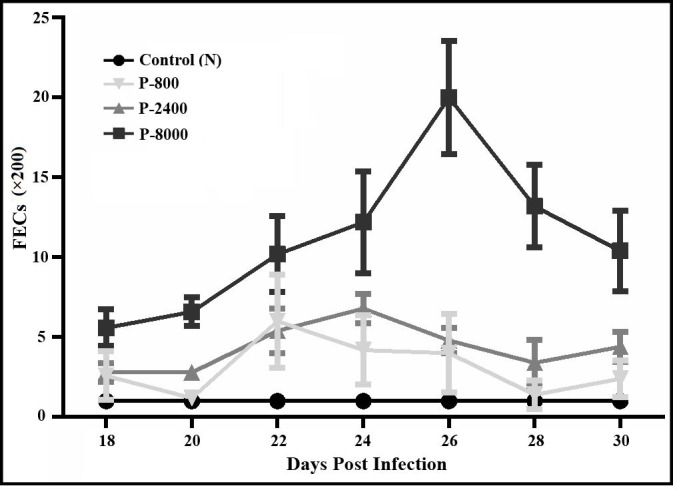
Fecal eggs count of goats at different days post-infection (DPI).Eggs were detected at 18 to 30 DPI while no eggs were detected at 0, 7 and 14 DPI.